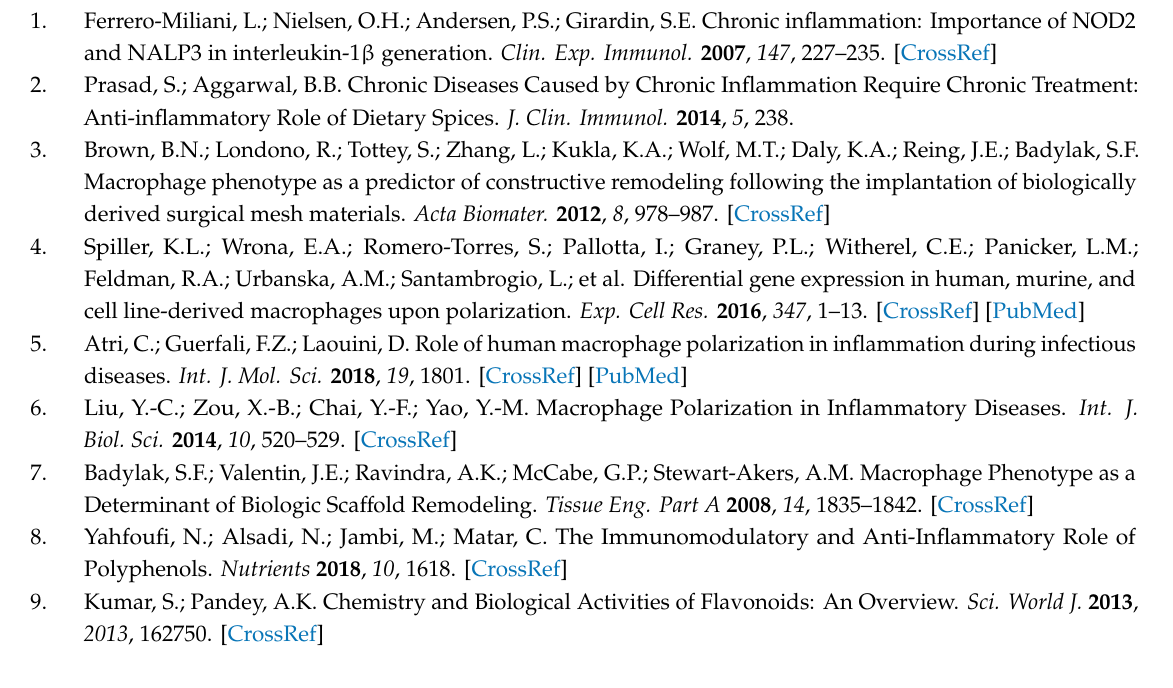
(PE); Figure S2: Identification of phosphatidylcholine (PC); Figure S3: Identification of phosphatidylinositol (PI); Figure S4: Identification of phosphatidylglycerol (PG); Figure S5: Identification of phosphatidylserine (PS); Figure S6: Identification of sphingomyelin (SM); Figure S7: Identification of lyso-phosphatidylcholine (LPC); Figure S8. Multivariate analysis of LC-MS data collected for M0 (grey circles) and M1 (red squares)